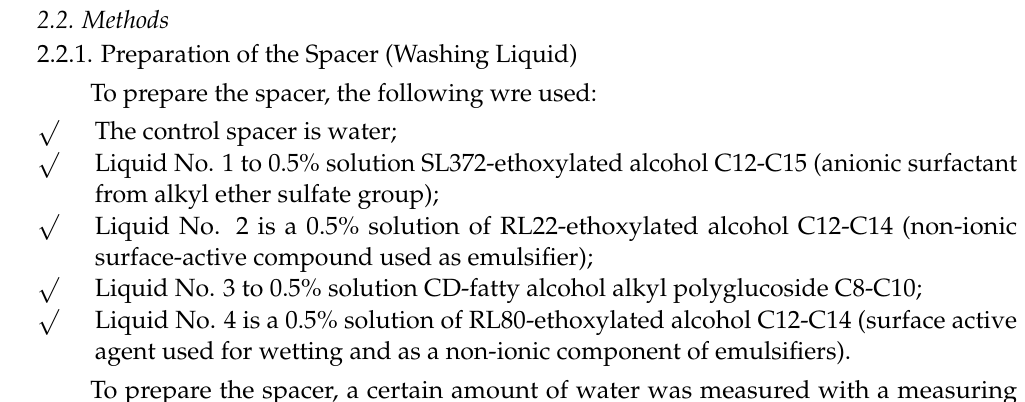
Table 1. Recipe and parameters of the cement slurry used in the test of adhesion on the hardened cement slurry–rock contact. Ingredients % by Mass of Cement Water–cement ratio 0.46 Plasticizer 0.2 Latex 8.0 Stabilizer 1.0 Defoaming agent 0.48 Antifiltrating agent 0.22 Setting accelerator 4.2 Microcement 10.0 Cement CEM I 42.5R